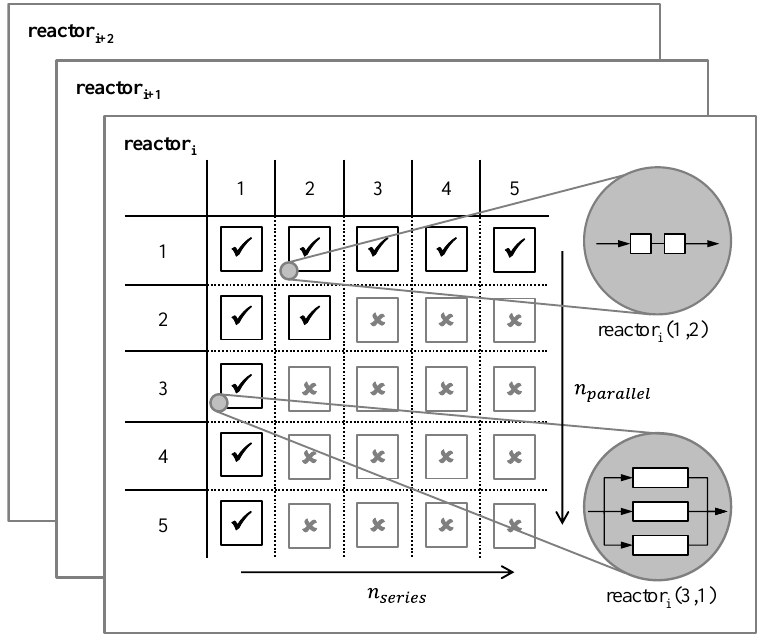
Figure 2. Interconnection matrix for different reactor systems exemplarily having five single reactor elements